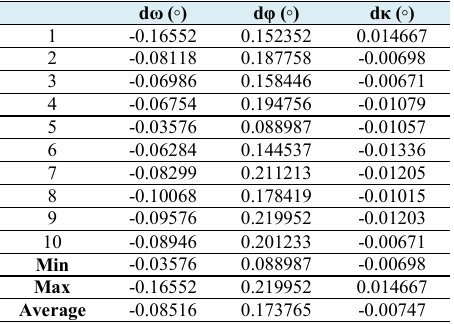
Table 4. Relative orientation between sensors, computed from the estimated EOPs.